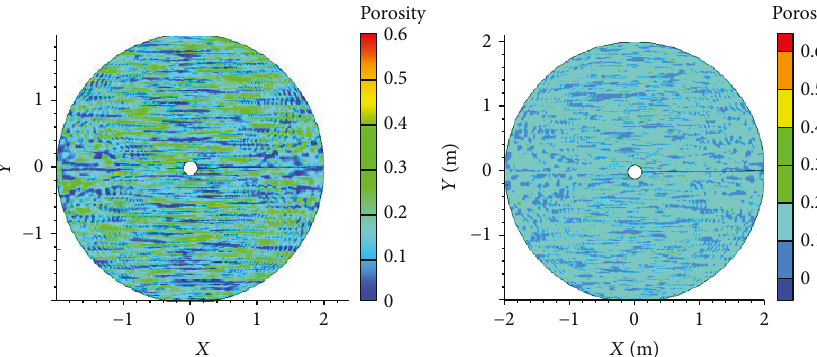
= 0 08, l = 0 0001 x y